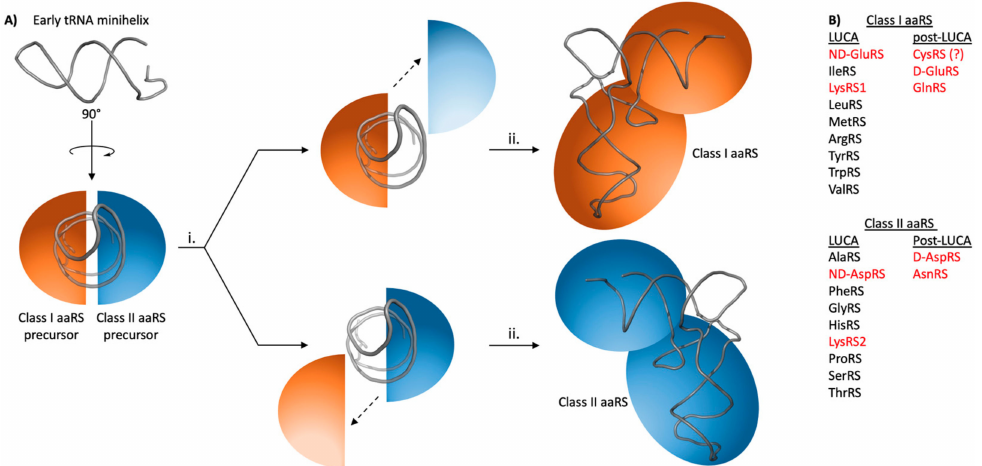
Figure 2. Cartoon schematic of early aaRS evolution. ( A ) A schematic summary of early aaRS evolution. Very early aaRS precursors are predicted to have aminoacylated tRNA micro- or mini- helices with substrate promiscuity. One minihelix would be recognized simultaneously by class I and class II precursors. Gene duplication (i) would have allowed these early aaRS precursors to achieve greater substrate specificity as they (ii) acquired additional domains like the anticodon-binding domains shown here to become the ancestors of modern aaRSs. Figure adapted from [8,16]. ( B ) List of aaRSs that existed at LUCA versus those that emerged post-LUCA. Enzymes discussed in this article are highlighted in red. CysRS might have existed at LUCA or emerged post-LUCA; this possibility is noted with a question